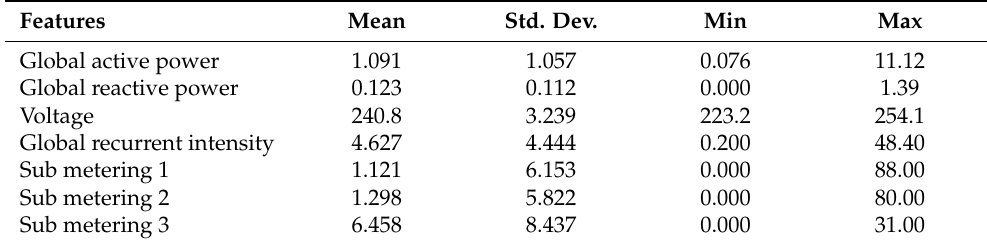
Table 2. Descriptive statistics of the dataset